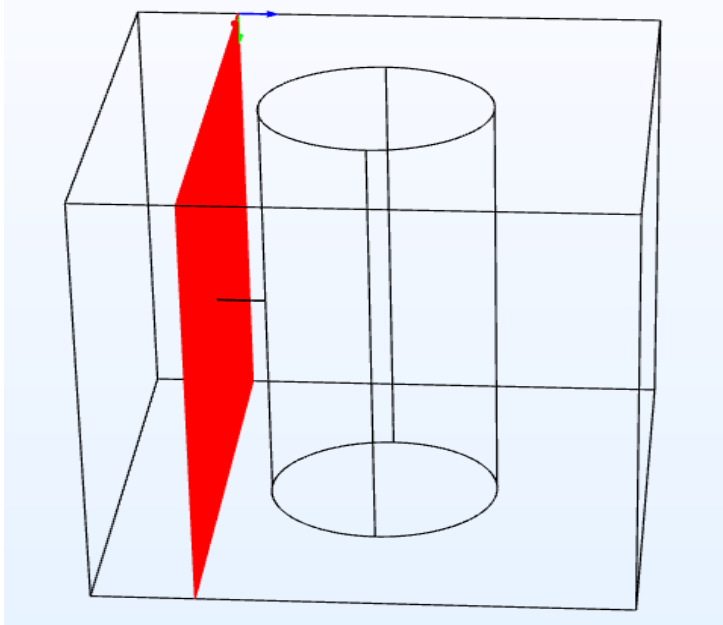
Figure 10. Variation in volume fraction of slurry solid particles δ with grouting time t : ( A ) 10 min,